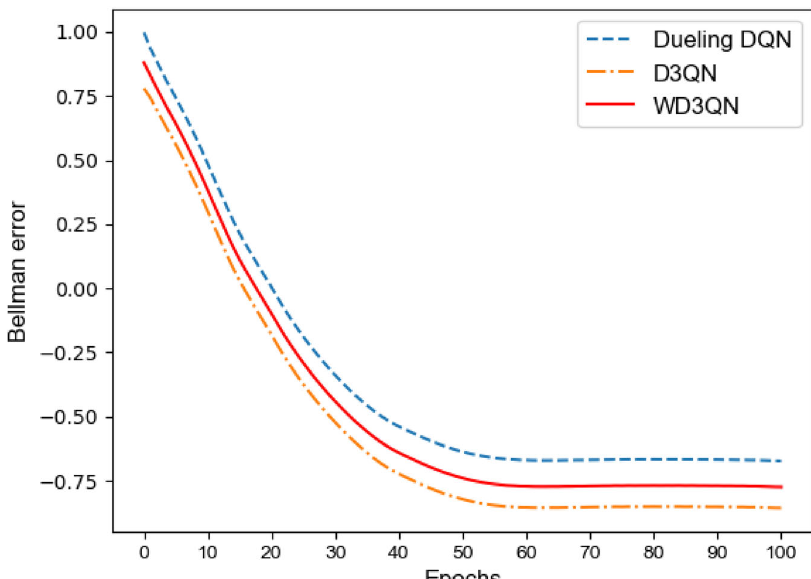
Fig. 5 Bellman error as a function of epochs. Visualization of Bellman error evolution. The WD3QN is shown in red. The Dueling DQN is shown in blue while the D3QN is shown in